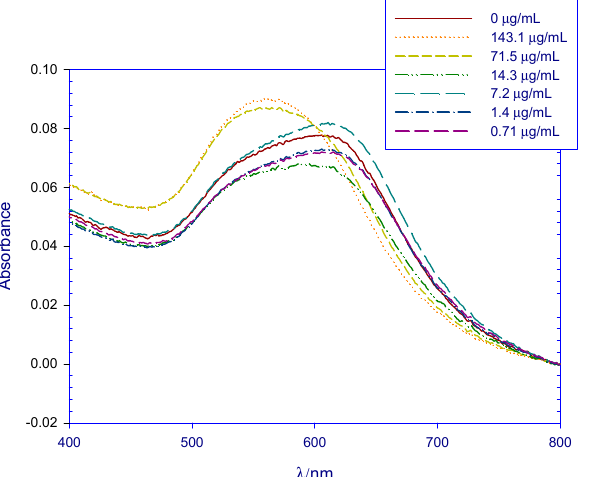
Figure 2. Normalized absorbance spectra for different concentrations of a urinary lysozyme. Series correspond to sample 1.